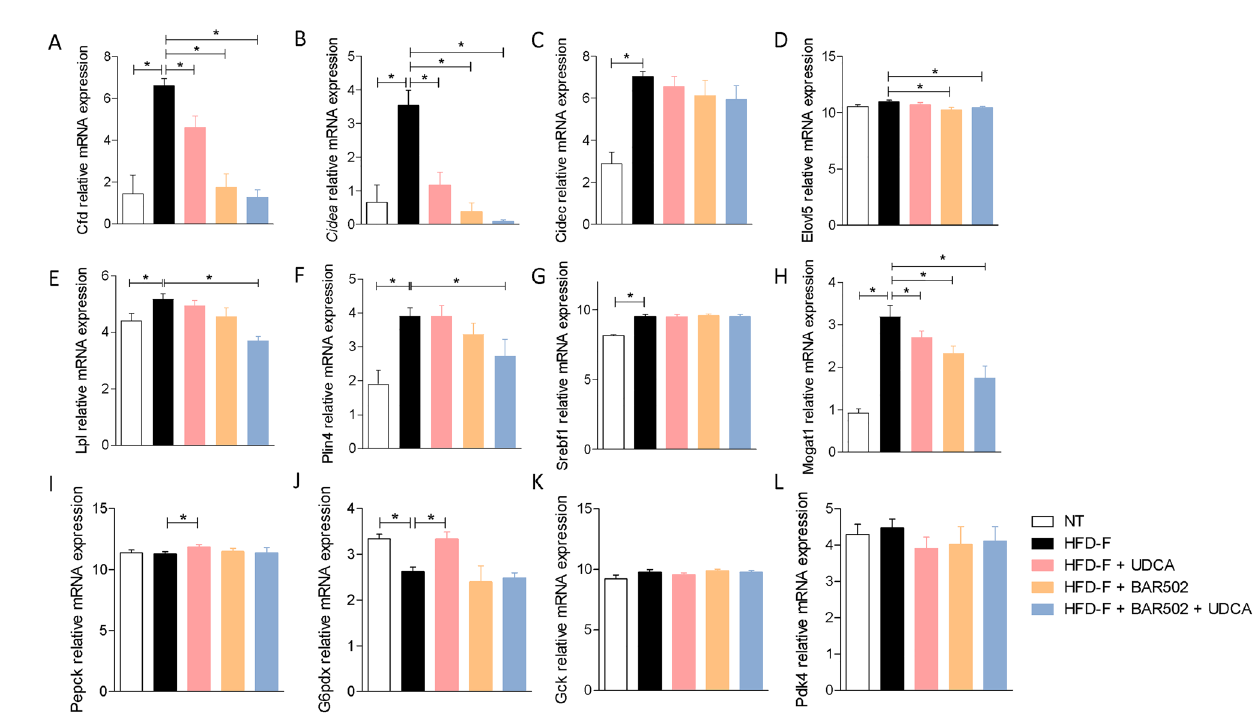
Figure 4. Expression levels of genes involved in lipid metabolism, extracted from RNA-seq analysis: ( A ) Cfd, ( B ) Cidea, ( C ) Cidec, ( D ) Elovl5, ( E ) Lpl, ( F ) Plin4, ( G ) Srebf1, ( H ) Mogat, ( I ) Pepck, ( J ) G6pdx ( K ) Gck, ( L )